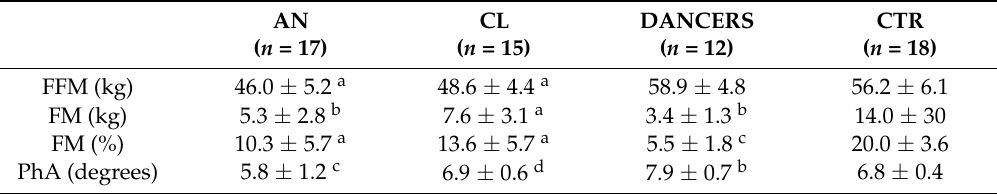
Table 2. Body composition of 62 males individuals, according to leanness groups.